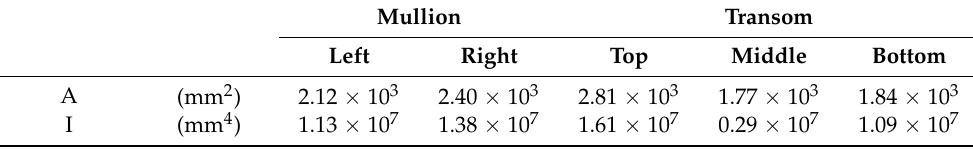
Table 1. Nominal properties of the frame. Key: A= cross-sectional area, I= second moment of area. Mullion